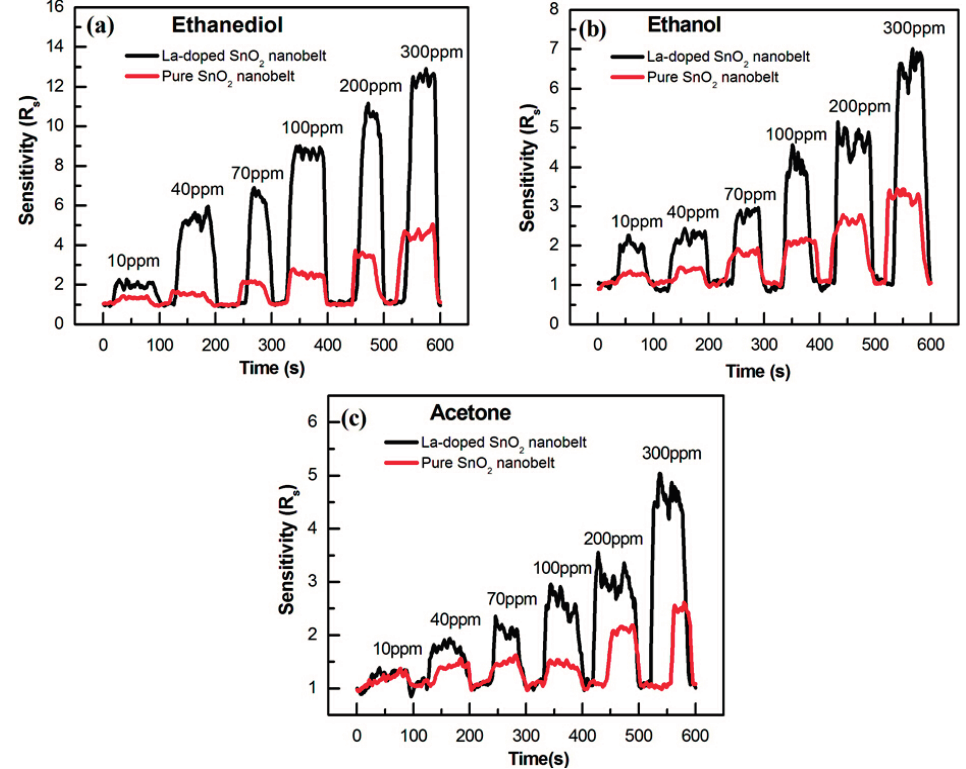
Figure 7. The gas sensitivity of two devices to ( a ) ethanediol; ( b ) ethanol and ( c ) acetone from 10 ppm to 300 ppm at 230